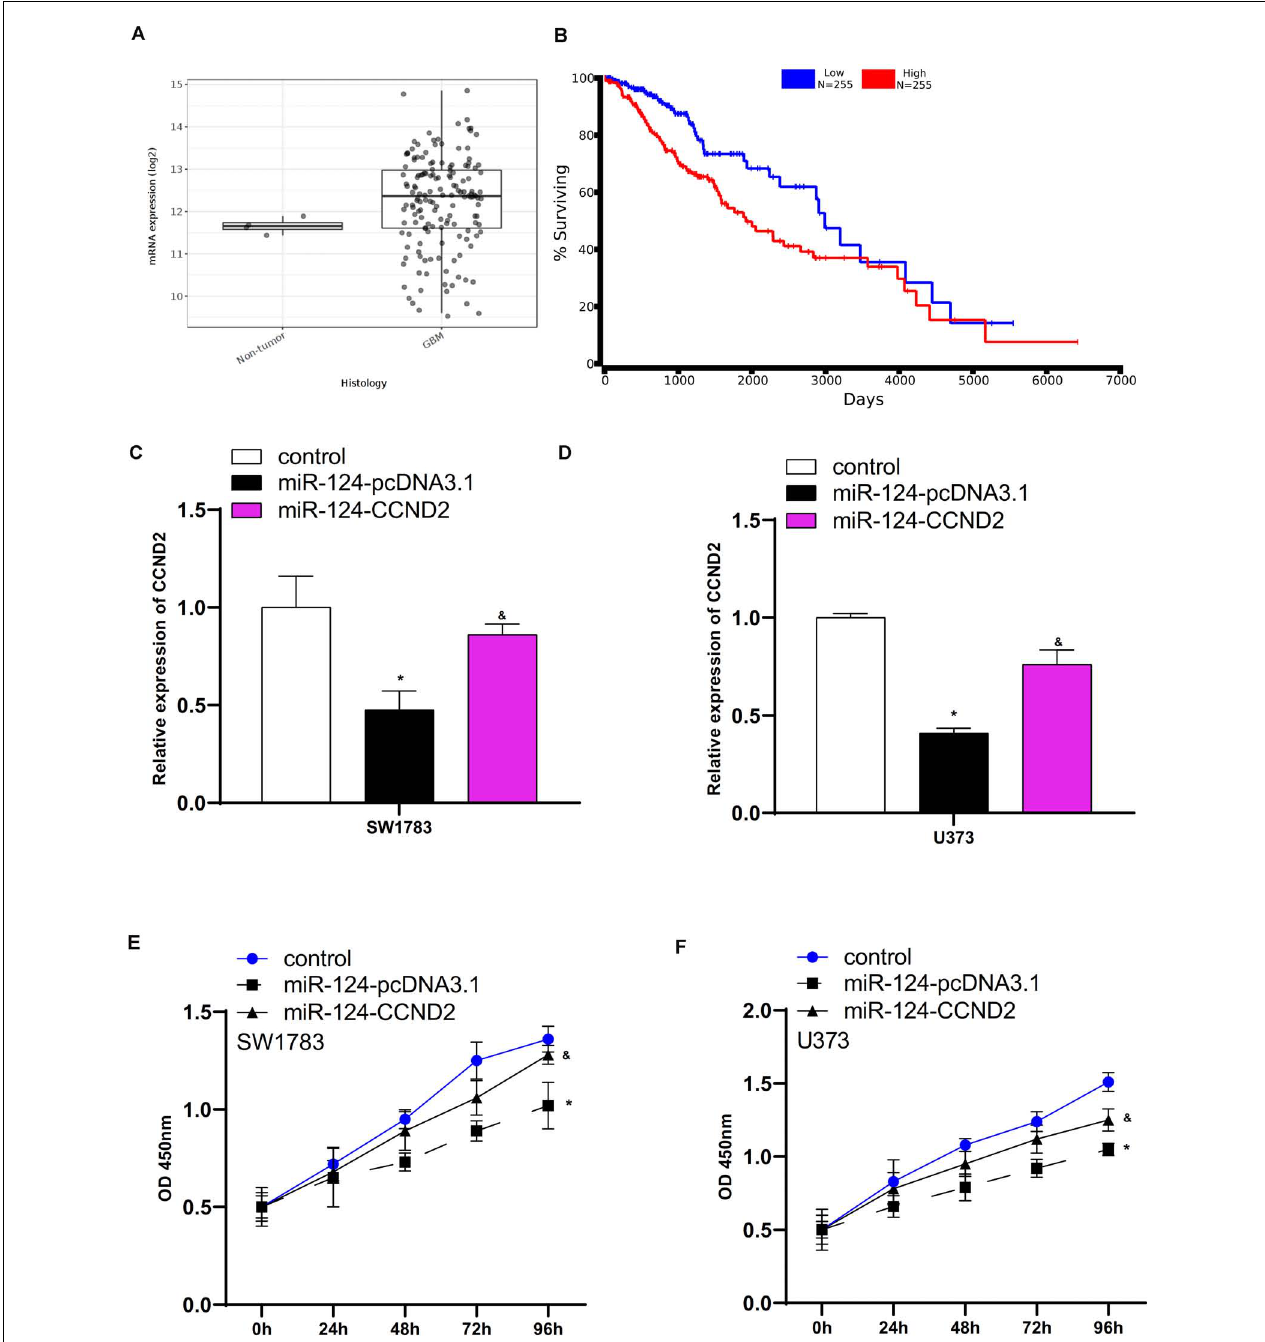
FIGURE 8 | CCND2 mediated the effects of miR-124 on glioma cells. (A) CCND2 was up-regulated in glioma samples. (B) Correlation between CCND2 expression level and overall survival time of GBM patients. (C,D) Overexpression of CCND2 markedly induced CCND2 levels in SW1783 and U373 cells transfected with miR-124. (E,F) The reduced cell growth in miR-124 overexpression cells were suppressed by up-regulation of CCND2. ∗ p < 0.05. The sign "&" indicates significant difference between non-control groups, p < 0.05.